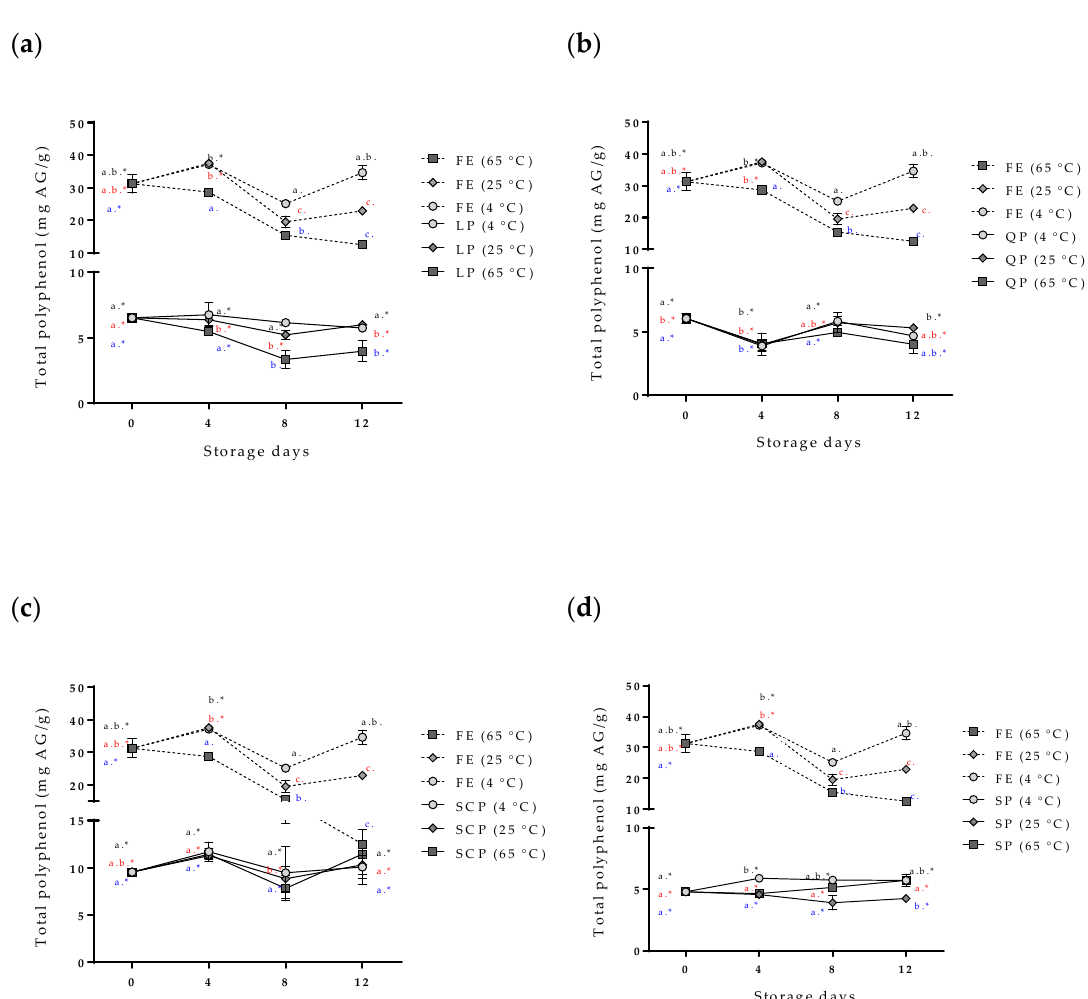
Figure 6. E ff ect of storage time and temperature of total polyphenol compounds isolated from the free and encapsulated annatto extracts. ( a ) Free and encapsulated extracts with lentil proteins, ( b ) free and encapsulated extracts with quinoa proteins, ( c ) free and encapsulated extracts with sodium caseinate, and ( d ) free and encapsulated extracts with soy proteins. FE: free extract, LP: lentil protein, QP: quinoa protein, SCP: sodium caseinate, SP: soy protein. Di ff erent superscript letters (a–c) within figure indicate significant di ff erences between storage days in the same sample ( p < 0.05) and samples marked with “ ∗ ” are not significantly di ff erent between the samples at same storage day ( p < 0.05). Both di ff erences according to Fisher’s least significant di ff erence (LSD-Fisher) test.